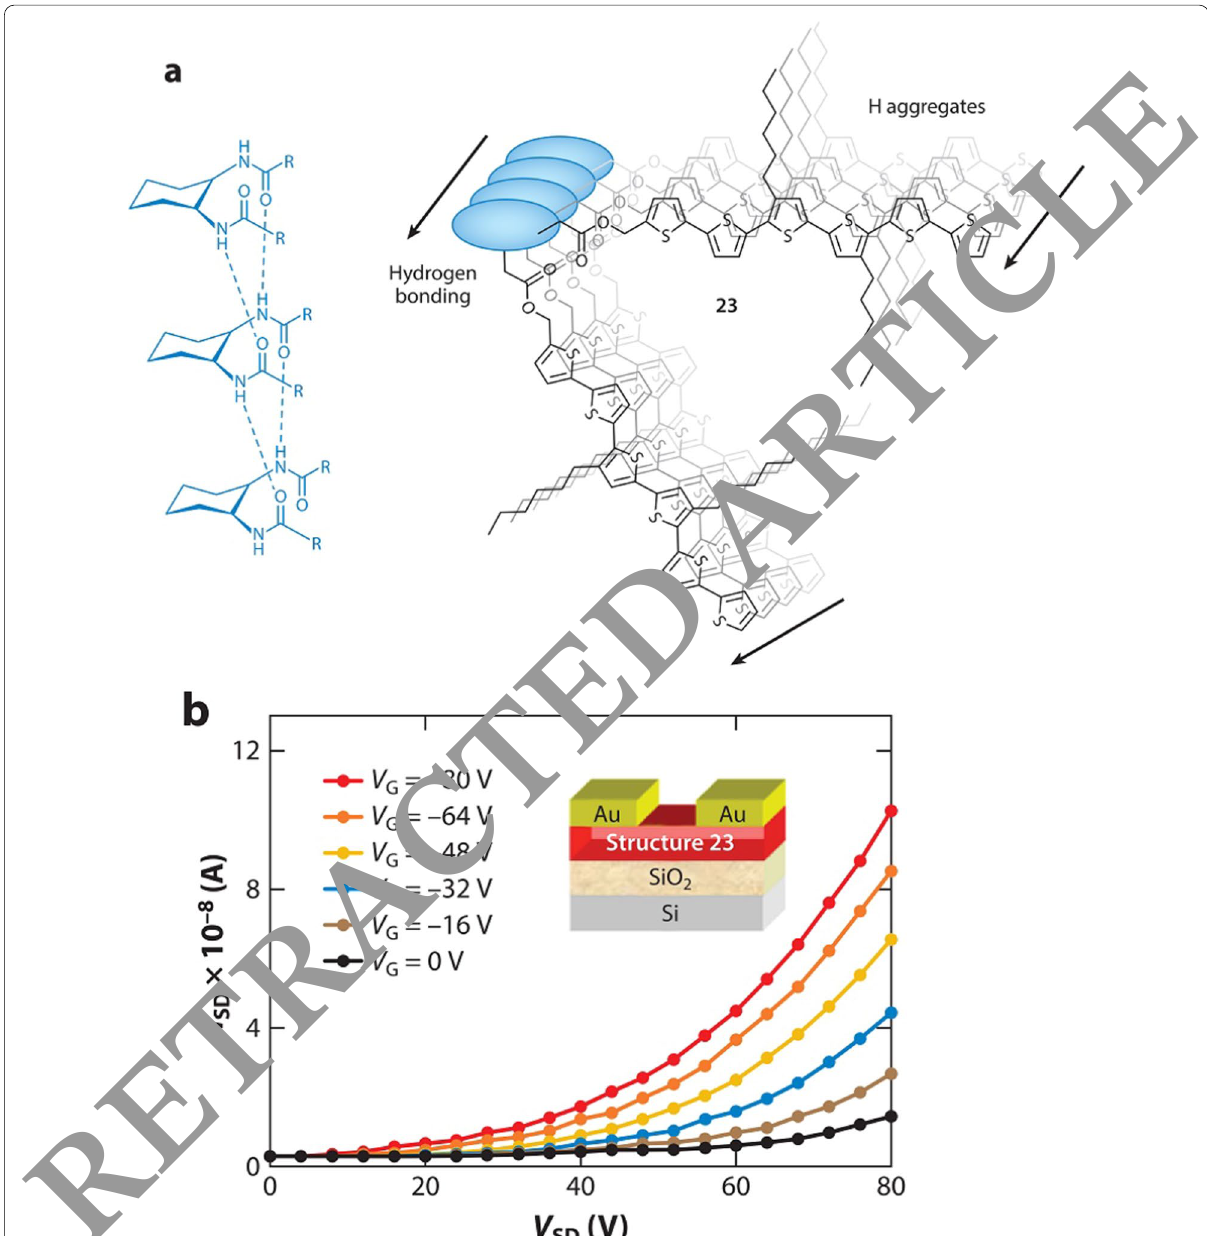
Fig. 10 a Schematic of the chemical structure of the self-assembling molecule 23; b current–voltage diagram for a field-effect transistor based on structure 23 in terms of gate voltage (VG) and discharge terminal voltage (VSD). The transistor is of type n, and its gate terminal is located below the discharge and source terminals